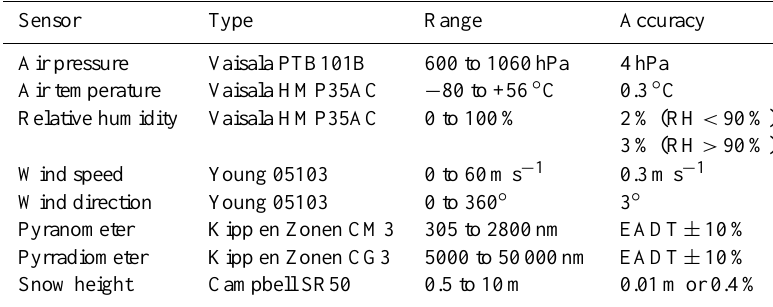
Fig. 1. Left: MODIS scene of west Greenland (23 August 2006) with AWS locations (white dots) and ice sheet elevation contours (dashed lines, height interval 250m, from Bamber et al., 2001). Inset shows location of Summit. Right: images of AWS locations at S5 (27 August 2006), S6 and S9 (both 26 August 2006). Table 1. AWS sensor specifications. EADT = Estimated Accuracy for Daily